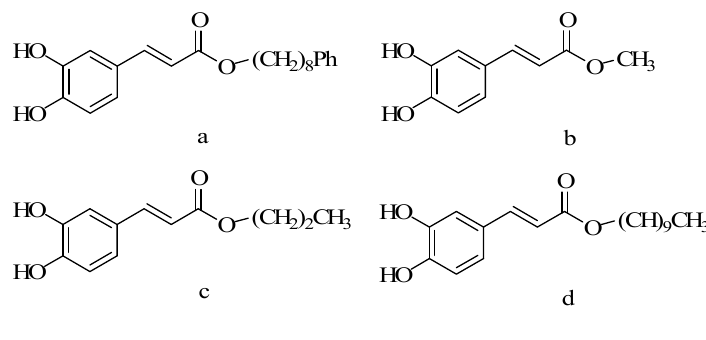
Figure 17. The structure of elongation of alkyl derivatives of